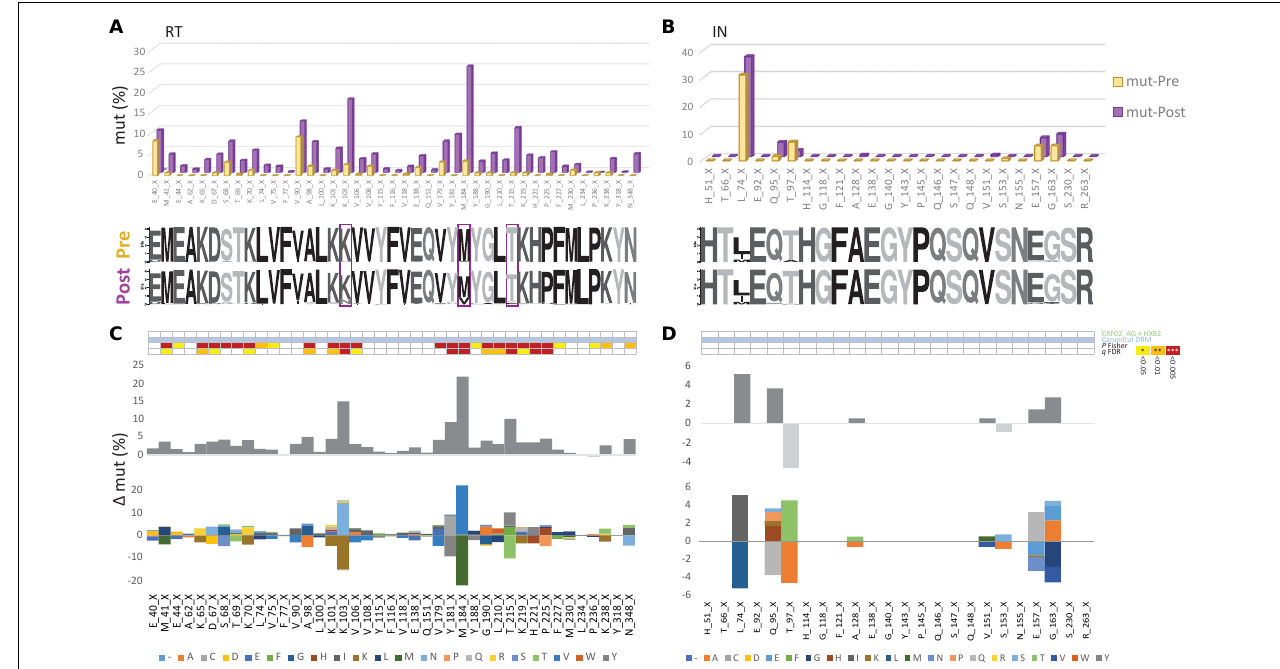
FIGURE 4 | Canonical drug resistance mutations of HIV-1 RT and IN sequences from Cameroon before and after regional implementation of cART. (A,B) Comparison of site-specific frequencies at canonical drug resistance mutation (mut) sites in Cameroonian HIV-1 pol RT (left) and IN sequences (right) before (yellow, Pre) and after (purple, Post) regional implementation of cART. CRF02_AG consensus sequences (derived from pre-cART data sets) served as references to call mut variants per site. The dominant (consensus) amino acid is indicated for each site, followed by the position in RT. X indicates any mutation/minority variant. Below the bar chart, weblogos of amino acid occurrences per site are shown for both Pre and Post data sets. Sites at which DRM frequencies increased by more than 10% from pre- to post-cART period are boxed. (C,D) Same selection of all canonical DRM sites in RT and IN [as in (A,B) , referring to blue annotations in Figure 3 ]. On the y-axis, the difference in mut percentage ( (cid:49) mut) between Post and Pre is indicated for each site, with increasing mut frequencies from Pre to Post shown as positive values (dark gray bars) and decreasing frequencies shown as negative values (light gray bars). The mirror bar chart below indicates all amino acid (aa) changes according to the bottom’s aa color code. The 4-row color strips on top indicate differences between CRF02_AG consensus sequences and HxB2 (green), sites of canonical drug resistance mut (DRM) sites (blue), and statistically significant differences between Pre and Post in Fisher Exact tests ( P values) and false discovery rates (FDR, q values), according to the legend to the